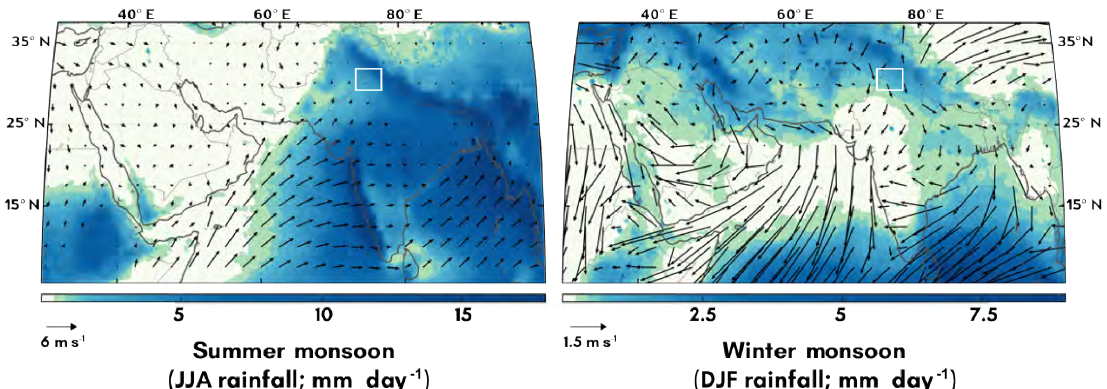
Figure 3. Modern seasonal climatology for South Asia. Average precipitation as well as wind direction and intensity for the summer (June– July–August or JJA) and winter (December–January–February or DJF) months are presented in the left and right panels, respectively. Note the differences in scales between panels for both rainfall and winds. Data used come from the ERA-40 reanalysis dataset (Uppala et al., 2005) for winds (averaged from 1958–2001) and the TRMM dataset (Huffman et al., 2007) for rainfall (averaged from 1998–2014). The white box encompasses the upper G-H